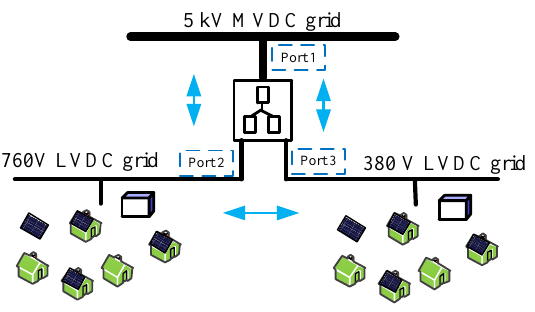
Figure 12. TAB converter connection medium-voltage direct current (MVDC) and low-voltage direct current